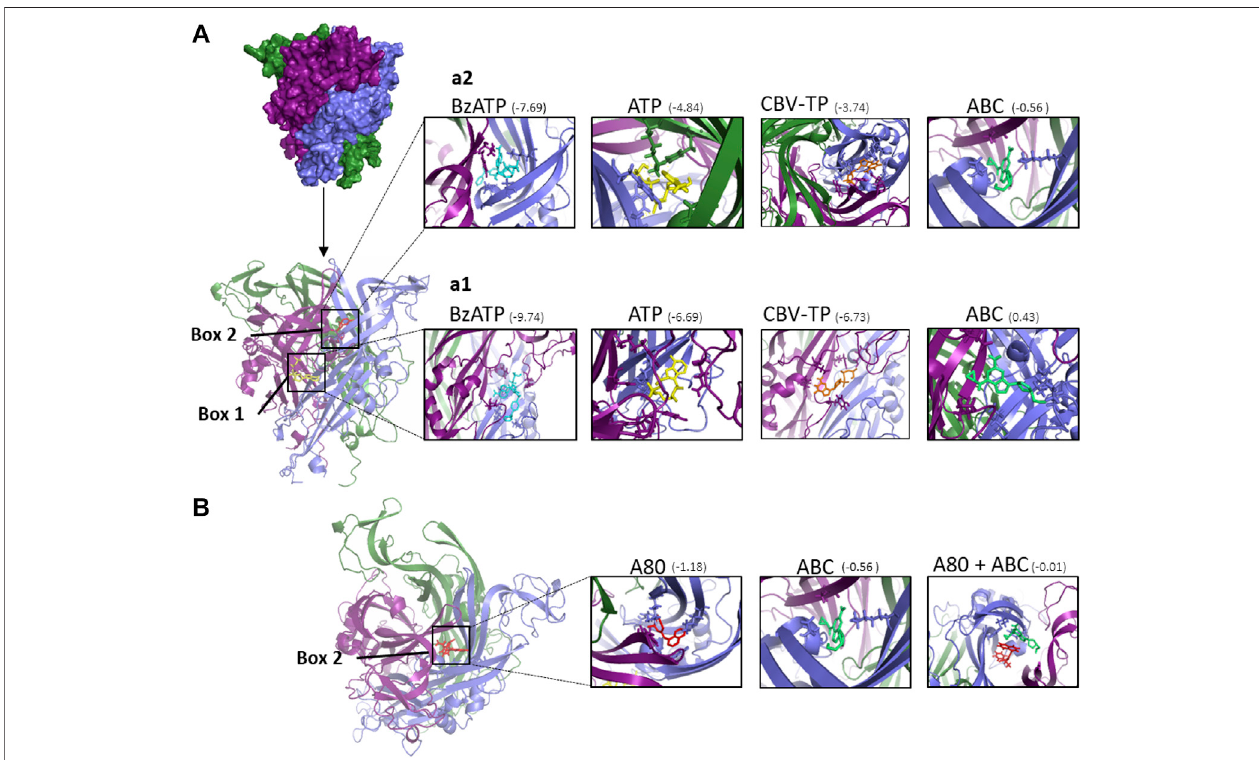
FIGURE7| DockingcalculationsofABCandotherligandstoP2X7receptor. (A) StructureofhumanP2X7RbuiltbyhomologymodelingbasedontheX-raycrystal structureofpandaP2X7R(5U2H).TheP2X7Rtrimerisrepresentedasamolecularsurface.Thethreemonomersarecoloredindeeppurple,slateblue,andforestgreen. Each monomer is shaped like a dolphin (Hattori and Gouaux, 2012). Docked poses at ATP binding site (box 1) and A804598 (A80) binding site (box 2) of the different compounds studied. The P2X7R trimer is represented as a cartoon. ATP is depicted in yellow, A804598 in red, Bz-ATP in blue and CBV-TP in orange and ABC in lime green. ( a1 ) Details of the ligands docked at box 1 showing some amino acid side chains at the interaction site. ( a2 ) Details of the ligands docked at box 2 showing some amino acid side chain at the interaction site. (B) Superimposition of docked poses of P2X7R antagonist A804598 (A80, in red) and ABC (in lime green) at the binding site two of the P2X7R. The predicted binding energies are indicated under parenthesis (kcal mol − 1 ).